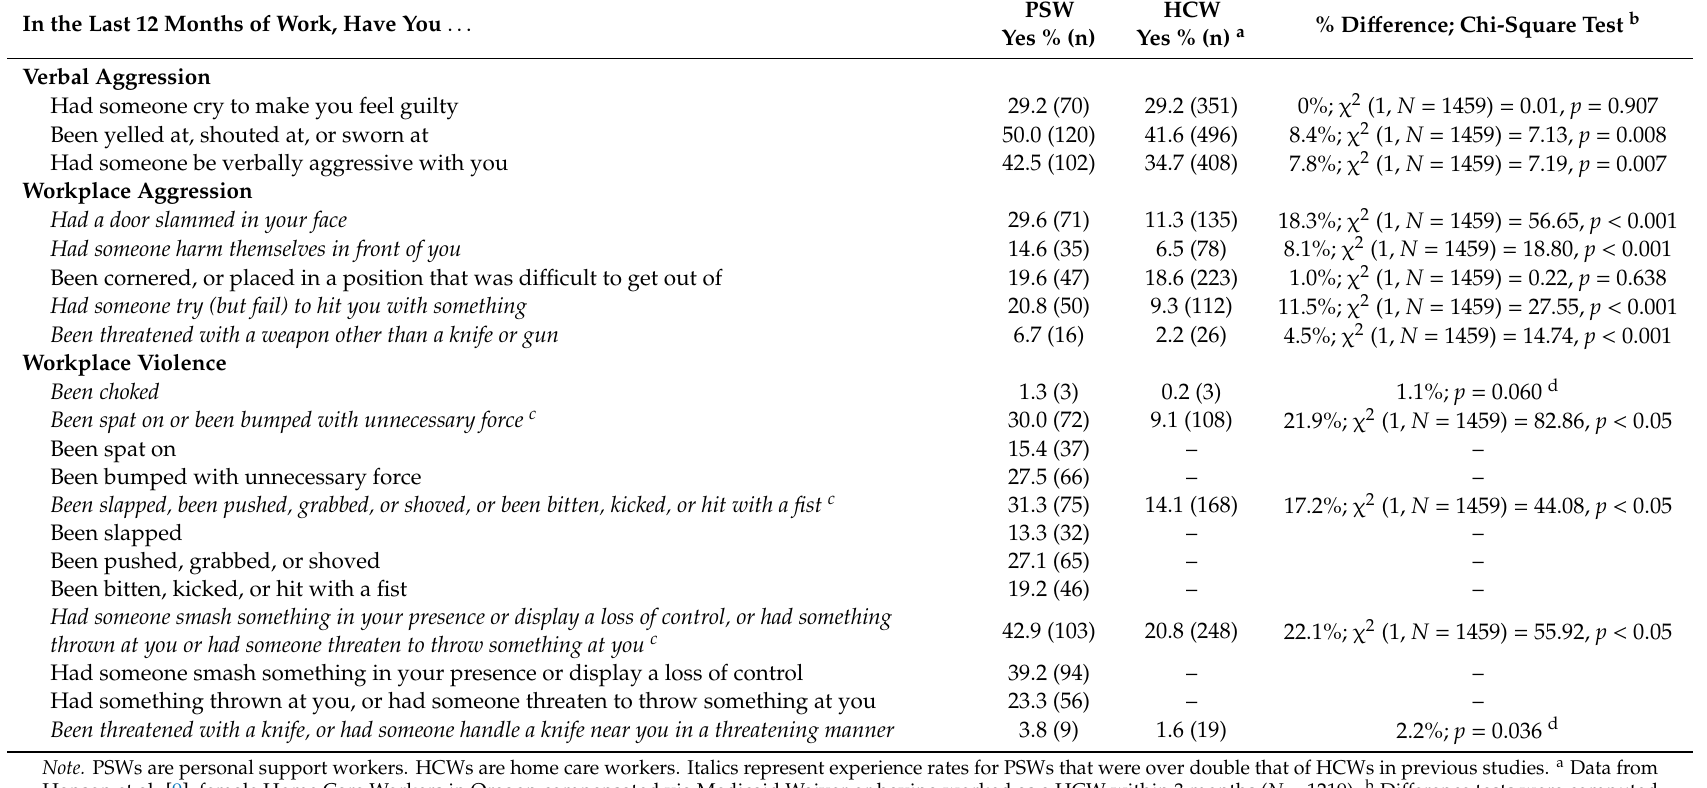
Table 2. Percentage of personal support workers (PSWs) experiencing challenging behaviors relative to home care workers (HCWs). In the Last 12 Months of Work, Have You